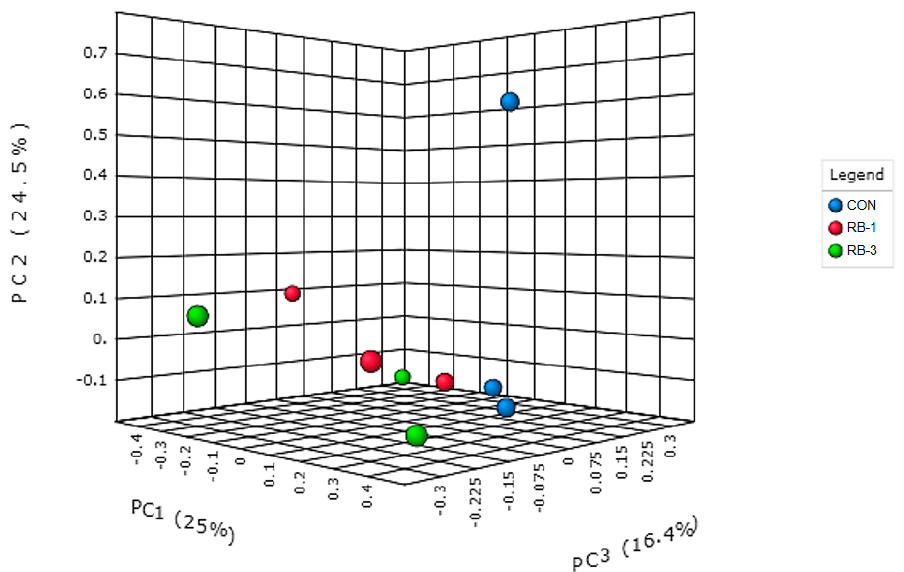
Figure 6. Bacterial beta diversity of the rumen digesta of Holstein Friesian cow after 5 days of treatment supplementation, showing a three-dimensional scatter plot, generated using principal coordinates analysis (PCoA) from Bray–Curtis index analyses [42]. Each treatment is identified by colors on the right side of the figure. Permutational multivariate analysis of variance (PERMANOVA) was used to compare beta diversities between treatments. CON (no buffer added), negative control; RB-1, (30% calcium oxide, 10% processed coral, 30% magnesium oxide, 30% sodium bicarbonate); RB-3 (20% calcium oxide, 10% processed coral, 40% magnesium oxide, 30% sodium bicarbonate).